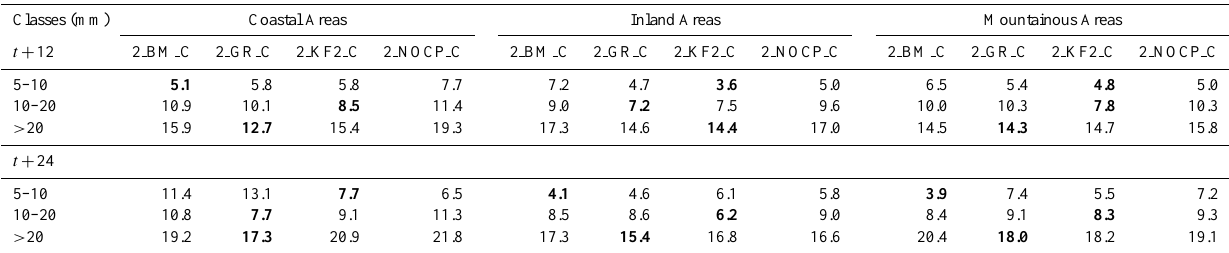
Table 10. Mean Absolute Error (MAE) (mm) for the three different CPSs and without CPS for three sub-areas of Epirus (a) coastal, (b) inland, (c) mountainous for 2km grid and Cressman method. The best values are presented in bold. Classes (mm) Coastal Areas Inland Areas Mountainous